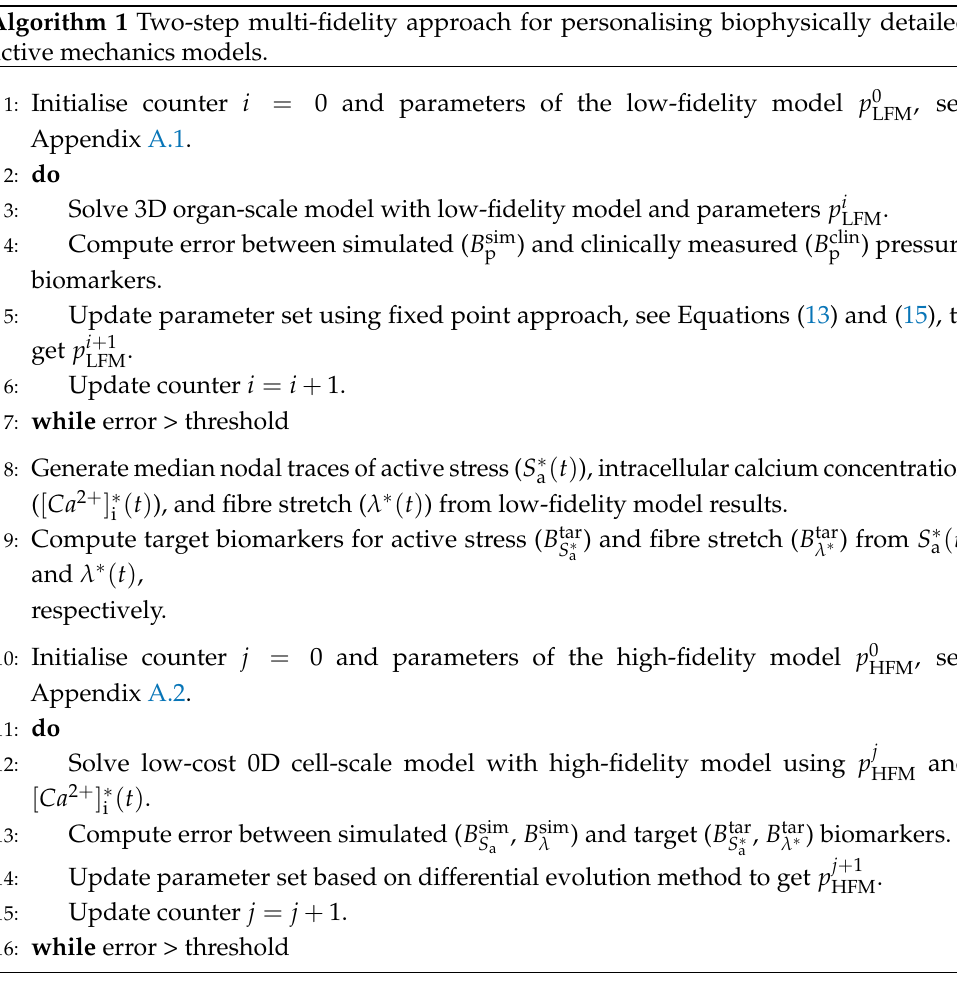
Algorithm 1 Two-step multi-fidelity approach for personalising biophysically detailed active mechanics